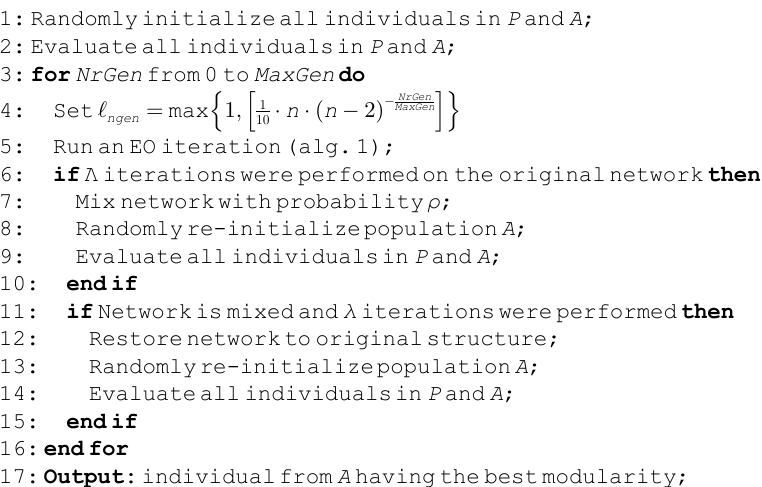
Algorithm 3 Outline of p - Mixed Network Extremal